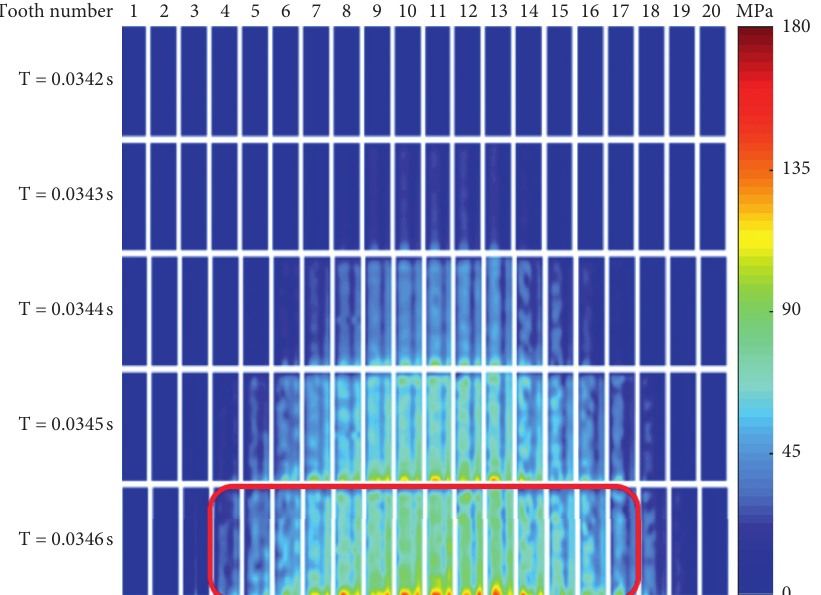
Figure 17: Real-time stress distribution of the contact area on axle spline surface under the identical loading case, at δ � 0.02mm.